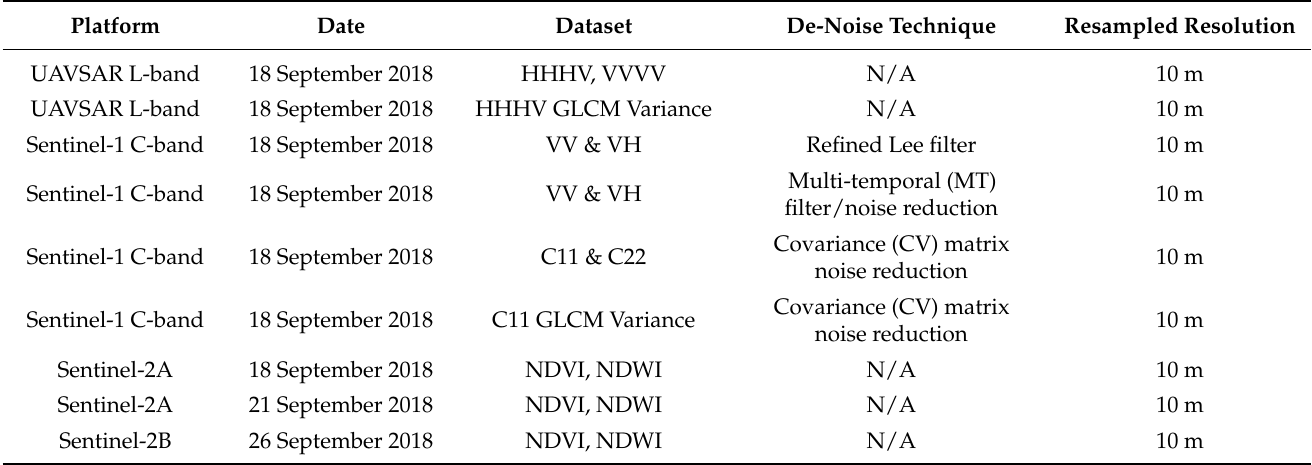
Table 1. SAR and multispectral datasets used in the first segment of this study are shown with the de-noising technique applied (if applicable) and the polarizations that were used. All of the SAR datasets were resampled to a common 10 m resolution and aligned with the Sentinel-2 multispectral